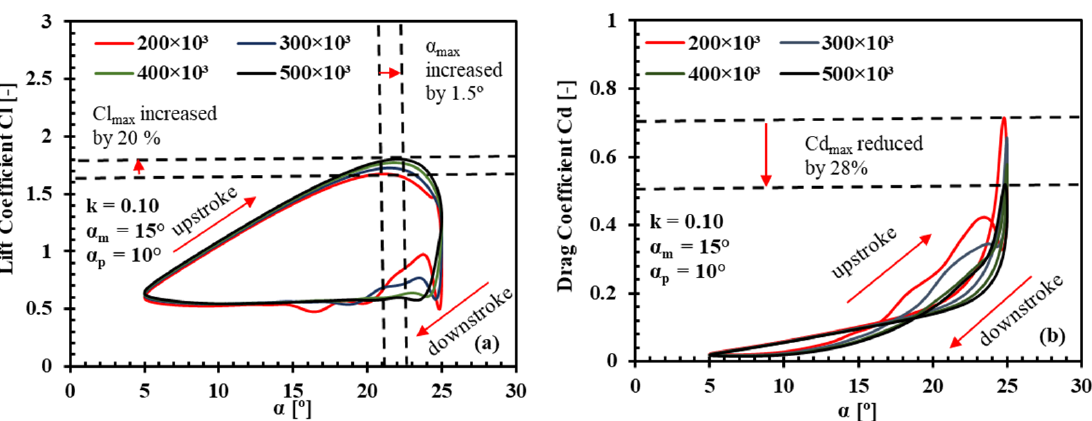
Figure 5. Comparison of hysteresis profiles for various Reynolds numbers for pitch oscillating airfoils: ( a ) Cl and ( b ) Cd at k = 0.10 and α m = 15°.